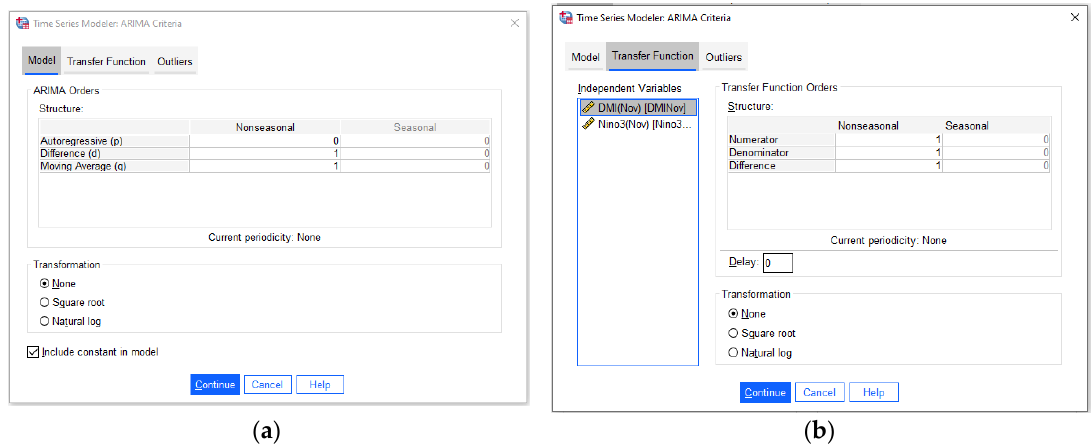
Figure A1. ARIMAX input for ( a ) model and ( b ) transfer functions.